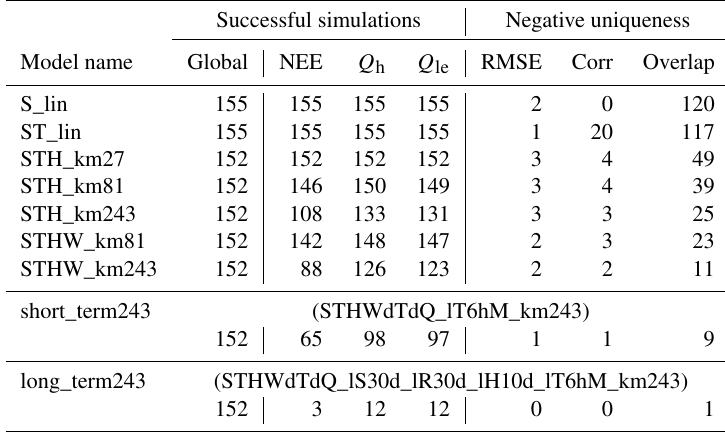
Table 1. Number of sites at which models ran successfully for global training (columns 1), the number of successful local simulations for each variable (columns 2–4), and the number of cases of negative uniqueness (indicating that the local model performed worse than the global model) for each of the three metrics (columns 5–7). Three sites (CA-Man, DE-RuR, and DE-RuS) did not include relative humidity, so all models including that variable failed, including the global model. The uniqueness calculations are sometimes, particularly in the case of correlation, prone to numerical error, so the threshold we use here is − 1 × 10 − 8 instead of zero. Successful simulations Negative